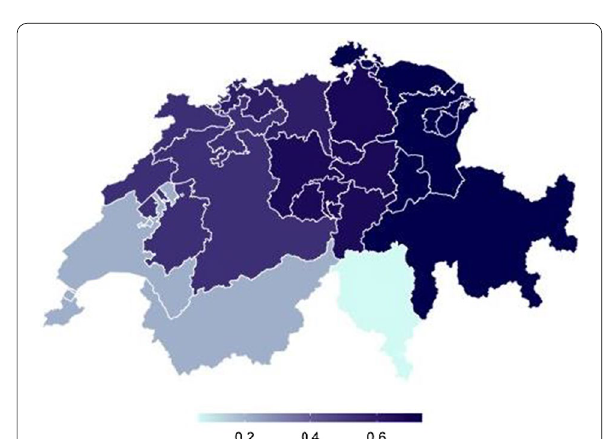
Fig. 4 Treatment effects by NUTS-2 regions. Correlation of Stringency Index and daily queries; linear model—specification as in Table 4, Panel A, column (1). Blue diamonds are the point estimates for the specific region accompanied by the 95% confidence interval. Vertical solid grey line (with grey shaded confidence interval) is the population average effect